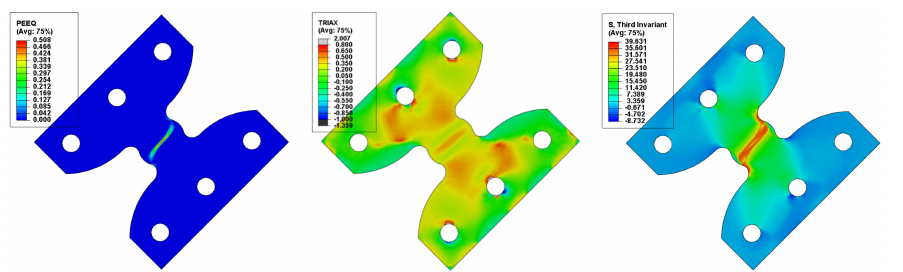
Figure 15. Equivalent plastic strain, stress triaxiality and third invariant distribution for the butterfly specimen oriented at 45 ◦ .